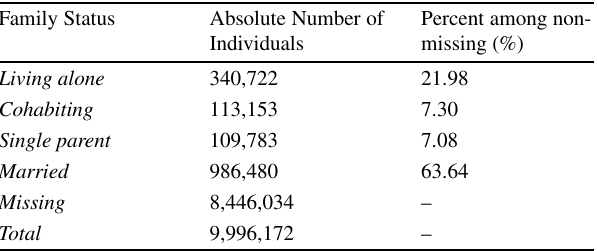
Table 4 Family Status of Individuals in Matched Couples Sample Family Status Absolute Number of Percent among non- Individuals missing